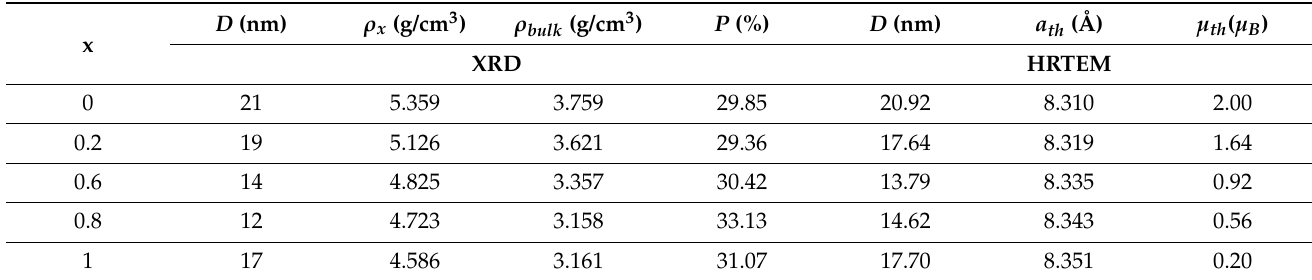
Table 2. Crystallite size ( D ), theoretical X-ray density ( ρ x ), bulk density ( ρ bulk ), porosity ( P ), and crys- tallite size, lattice parameter, and theoretical magnetic moment from HRTEM for Ni + 2 (x = 0, 0.2, 0.6, 0.8, and 1).